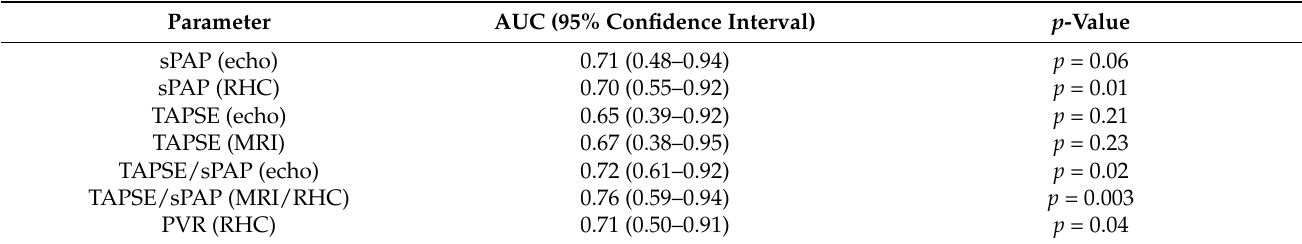
Table 3. Comparison of area under curve (AUC) of various parameters for prediction of combined endpoint (ROC analysis). Parameter AUC (95% Confidence Interval) p